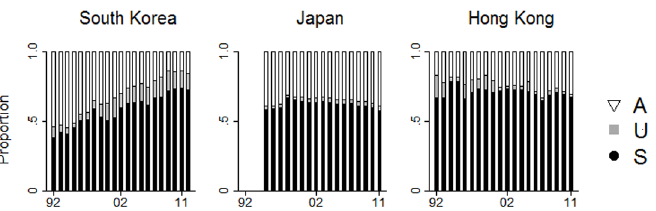
Fig 1. Annual proportional change of suicides, undetermined deaths, and accidental deaths in South Korea, Japan, and Hong Kong from 1992 to 2011.